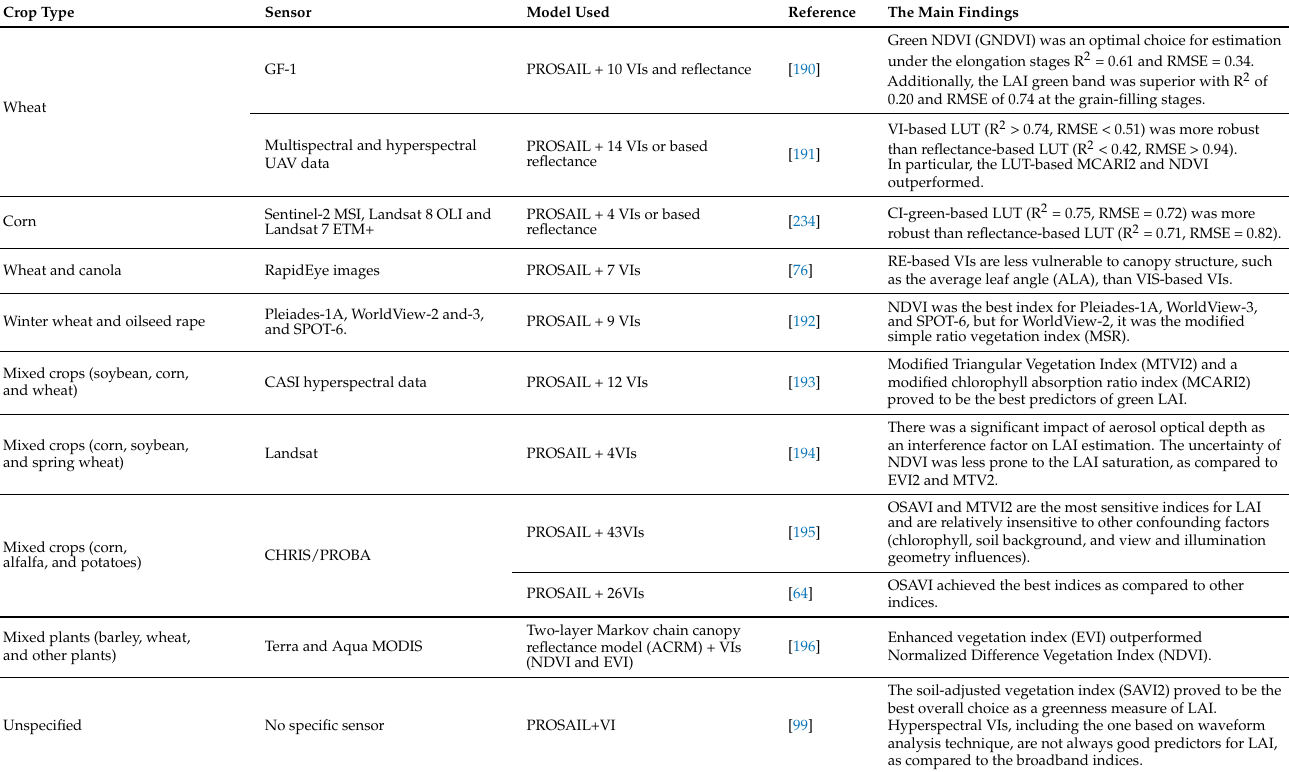
Table A1. Summary of LAI prediction using a parametric